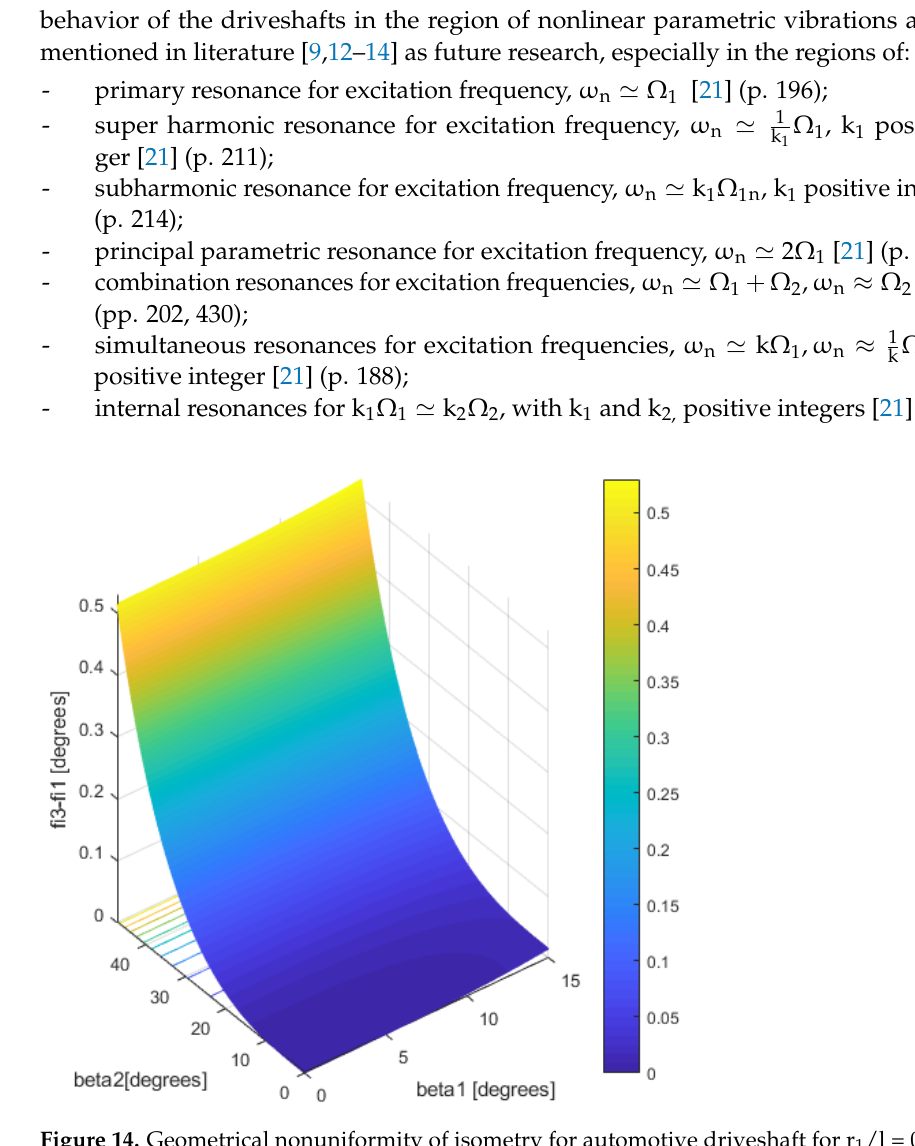
Figure 14. Geometrical nonuniformity of isometry for automotive driveshaft for r 1 /l = 0.11, r 2 /l = 0.09, φ 1 = constant = 243°.